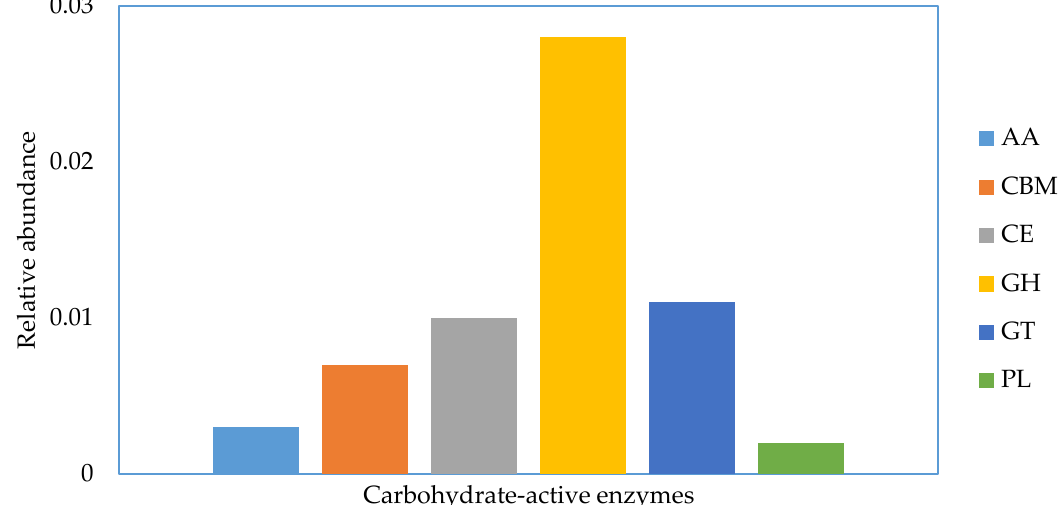
Figure 3. Relative abundance of the category of carbohydrate-active enzymes according to carbohydrate-active enzyme (CAZy) database. AA = Auxilliary Activities, CBM = Carbohydrate Binding Modules, CE = Carbohydrate Esterases, GH = Glycoside Hydrolases, GT = Glycosyl Transferases, PL = Polysaccharide Lyases.